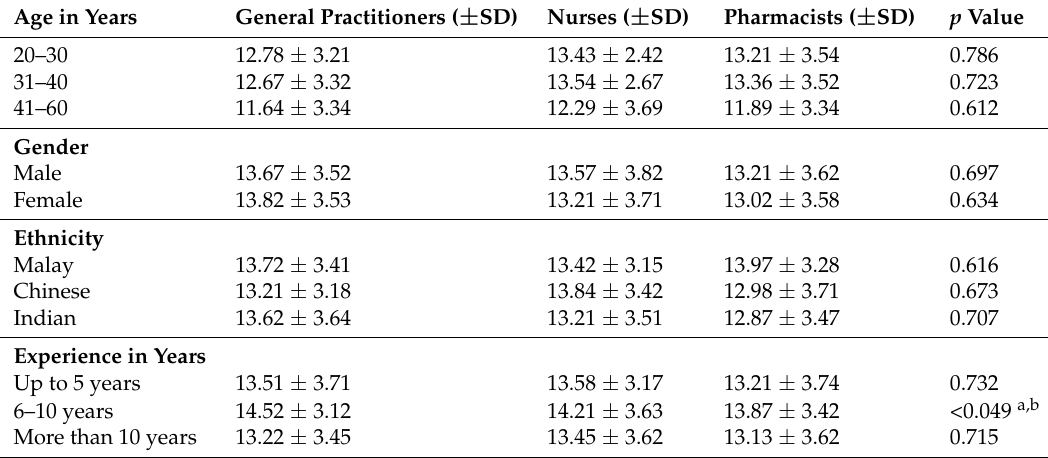
Table 4. Differences in preparedness among healthcare professionals by demographic